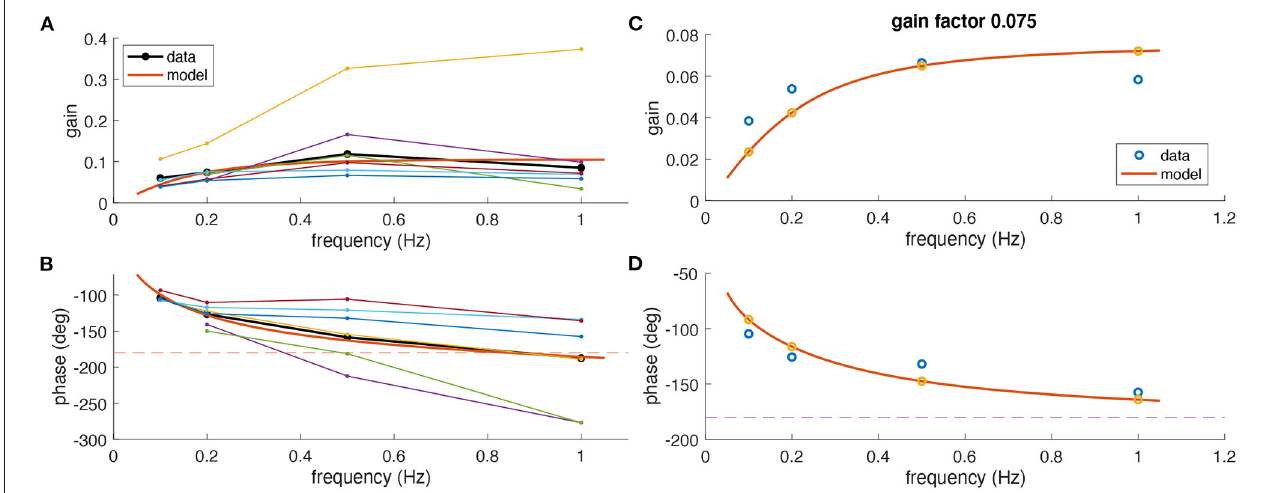
FIGURE 3 | Comparison of experimental and modeling data. (A,B) Experimental gain (A) and phase values (B) for eye movements of Xenopus tadpoles ( n = 6) (colored small dots) along with average gain and phase values (large black dots); the red curve depicts simulated gain and phase values obtained from the computational model (red line) of the tadpole aVOR that have been fitted to the average results (black); note that an eye movement with a phase shift of − 180 ◦ [dashed line in (B) ] and a gain of 1 would perfectly compensate for the head rotation at all frequencies. (C,D) Example experimental data (blue circles) obtained from one animal (same as in Figure 2 ) and modeling results (red curve, yellow circles), with gain and phase values plotted in (C,D) ,